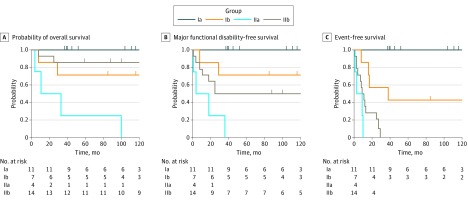
Probability of Survival for Patients with Childhood Cerebral X-linked Adrenoleukodystrophy Patients were stratified by neuroimaging before transplant and stem cell source. Group Ia (n = 11) comprised patients with favorable magnetic resonance imaging (MRI) and bone marrow donor; group Ib (n = 7), favorable MRI and other stem cell source; group IIa (n = 4), demyelination of cerebellum or basal ganglia; and group IIb (n = 14), other unfavorable MRI. Marks indicate censored patients.